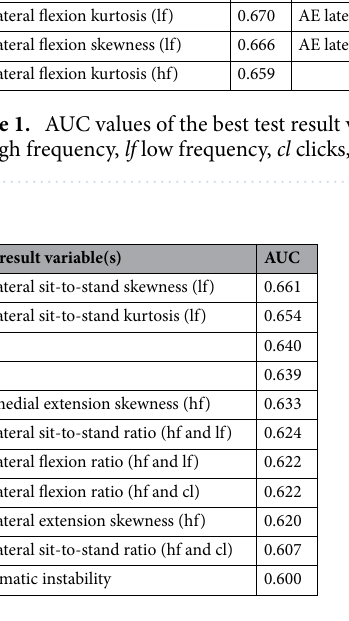
Table 2. AUC values of the best test result variables in males. AE acoustic emission, BMI body mass index, hf high frequency, lf low frequency, cl clicks, all high and low